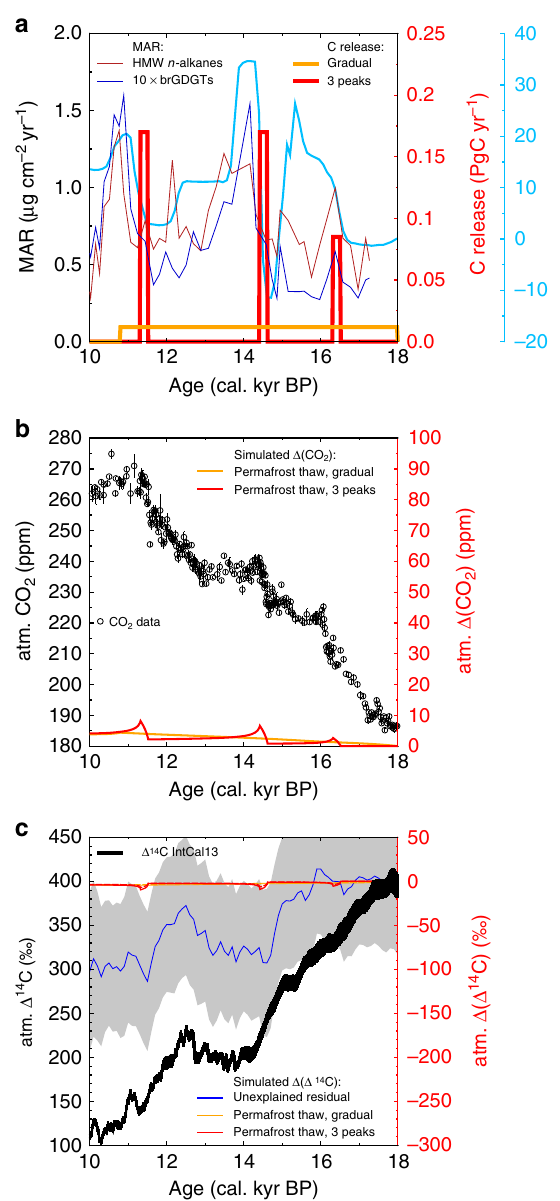
Fig. 4 Simulated impacts of sea level triggered coastal erosion and related permafrost thawing on atmospheric carbon reservoirs using the global carbon cycle model BICYCLE. a Assumed carbon release from permafrost thaw of 85 PgC from 18 to 10.8 kyrs BP, either gradual (orange) or in 3 short periods of 200 yr duration connected with rapid sea level rise (red). For comparison our new MAR data and a reconstruction of sea level change 14 are also shown. b Simulated anomalies in atmospheric CO 2 levels for the two carbon release scenarios and reconstructed CO 2 data (mean ± 1 σ ) from ice cores 12, 13 for comparison (data as in ref. 69 ). c Simulated anomalies in atmospheric Δ 14 C. The unexplained residual (mean (blue) ± 1 σ uncertainty (grey)) shows Δ ( Δ 14 C) that is not explained by changes in 14 C production rate. Anomalies in Δ 14 C caused by the two carbon release scenarios with difference in the pre-depositional ages of the released carbon (5 kyrs: broken lines; 10 kyrs: solid lines). IntCal13 11 atmospheric Δ 14 C for